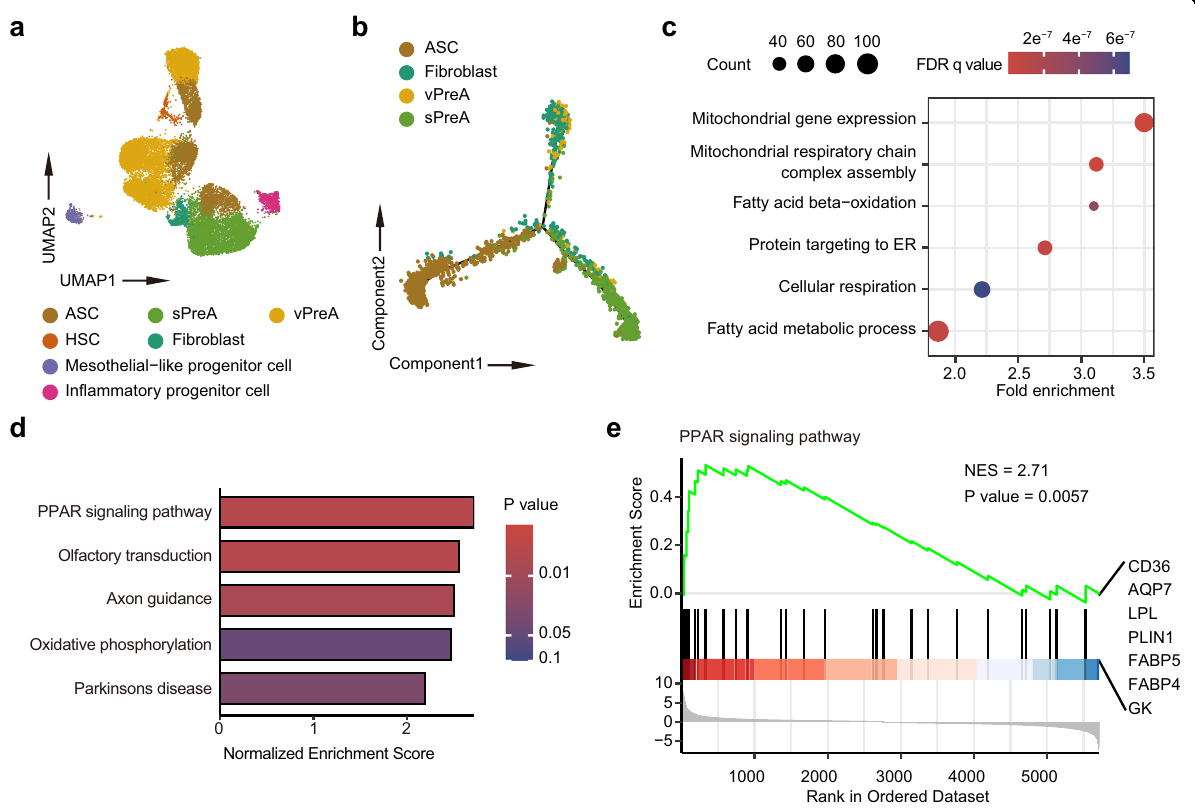
Fig. 2 Landscape of ASPCs. a UMAP plot showing seven manually annotated cell populations. b Pseudo-time trajectory map of adipogenic progenitor cells in SAT classi fi ed by manual annotation. c Dot plot showing the enriched biological processes among upregulated genes in preadipocytes from SAT. d Bar plot illustrating top 5 enriched Kyoto Encyclopedia of Genes and Genomes (KEGG) pathways among differentially expressed genes (DEGs) between preadipocytes from SAT and visceral adipose tissue (VAT) by Gene Set Enrichment Analysis (GSEA). e GSEA plot showing the enrichment of genes involved in peroxisome proliferators-activated receptor (PPAR) singling pathway among DEGs between VAT and SAT. Leading edge subset of genes involving in the pathway were labeled. HSC, hematopoietic stem cell; sPreA, subcutaneous preadipocyte; vPreA, visceral preadipocyte; ASC, adipose stem